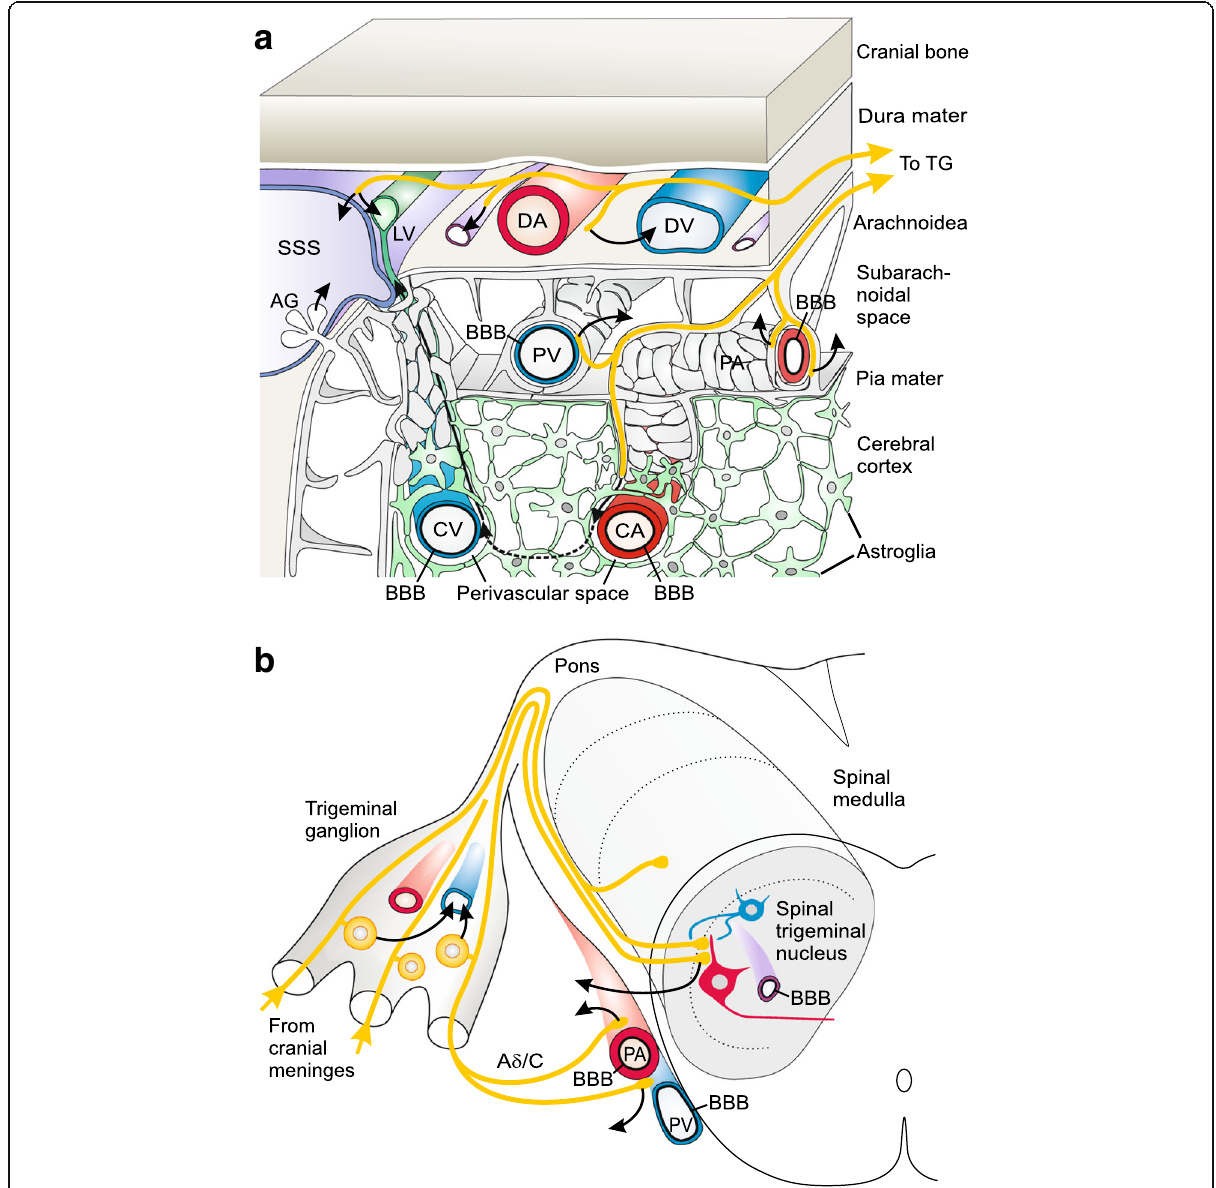
Fig. 1 Scheme of sources and sinks for CGRP (curved arrows) in the trigeminovascular system, a meninges, b trigeminal ganglion and spinal trigeminal nucleus. CGRP released from trigeminal afferent fibers innervating dural arteries (DA) is most likely taken up from capillaries, venous vessels (DV) and possibly the superior sagittal sinus (SSS), and is transported with the blood stream into the internal jugular vein. The same may occur in the trigeminal ganglion, which is located outside the blood-brain barrier (BBB). However, a BBB is functional in pial arteries (PA) and veins (PV). Thus, CGRP released from perivascular afferent fibres cannot enter the vessels but diffuses into the surrounding cerebrospinal rooms, the subarachnoidal space or the cerebello-medullary cisterna (cisterna magna), respectively, where it can be found in the cerebrospinal fluid (CSF). Probably part of it is secreted through the arachnoid granulations (AG) into the SSS and appears secondarily also in the jugular blood. CGRP released from the central terminals of trigeminal afferents within the spinal trigeminal may move out of the medulla into the cisterna magna. Innervated cortical arterioles (CA) arising from penetrating pial arteries may also be innervated by trigeminal afferents. Here, CGRP may be released into the perivascular space between the vessel wall and the surrounding astroglial end-feet. Then it may be transported with the glymphatic flow through the brain tissue and collected in the venous perivascular spaces. CGRP may move together with the extracellular fluid within these spaces along the venous vessels through the subarachnoidal space to the dura mater, where it may be finally collected in lymphatic vessels (LV) accompanying the